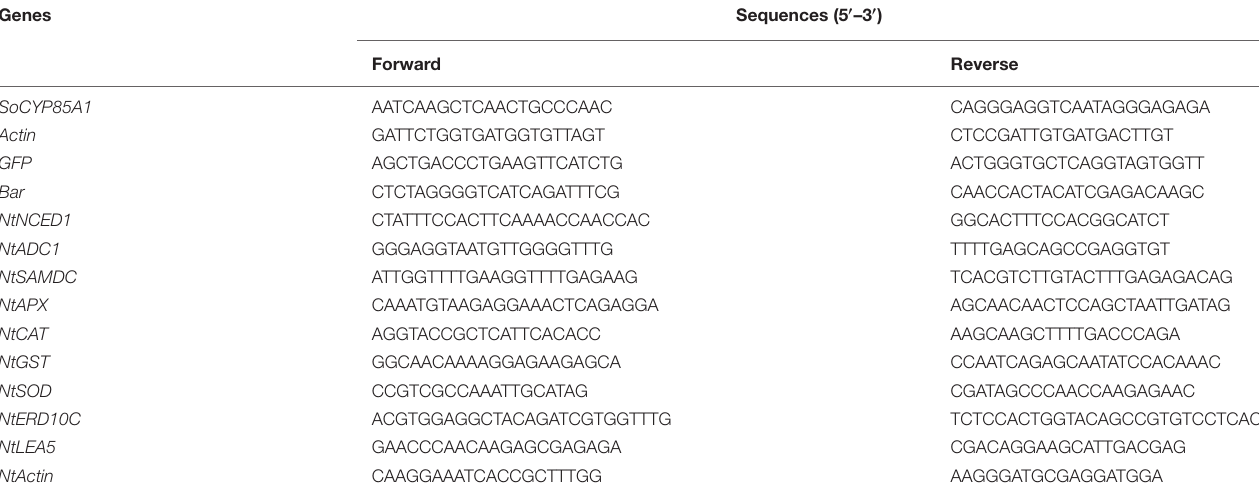
TABLE 2 | Sequences of primers in qRT-PCR. Genes Sequences (5 (cid:48) –3 (cid:48)